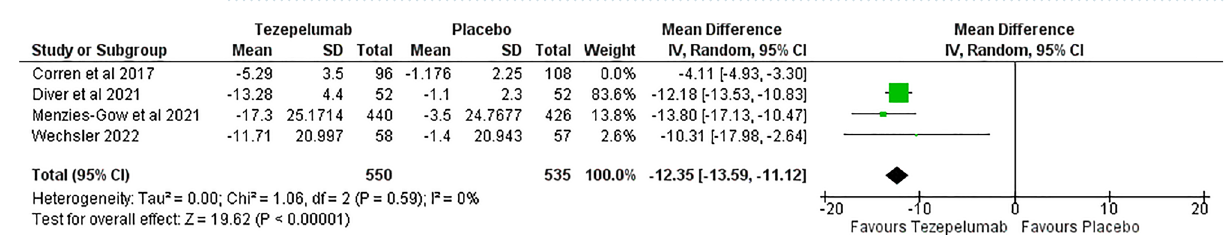
Figure 8. Change from the baseline in Blood eosinophil count.